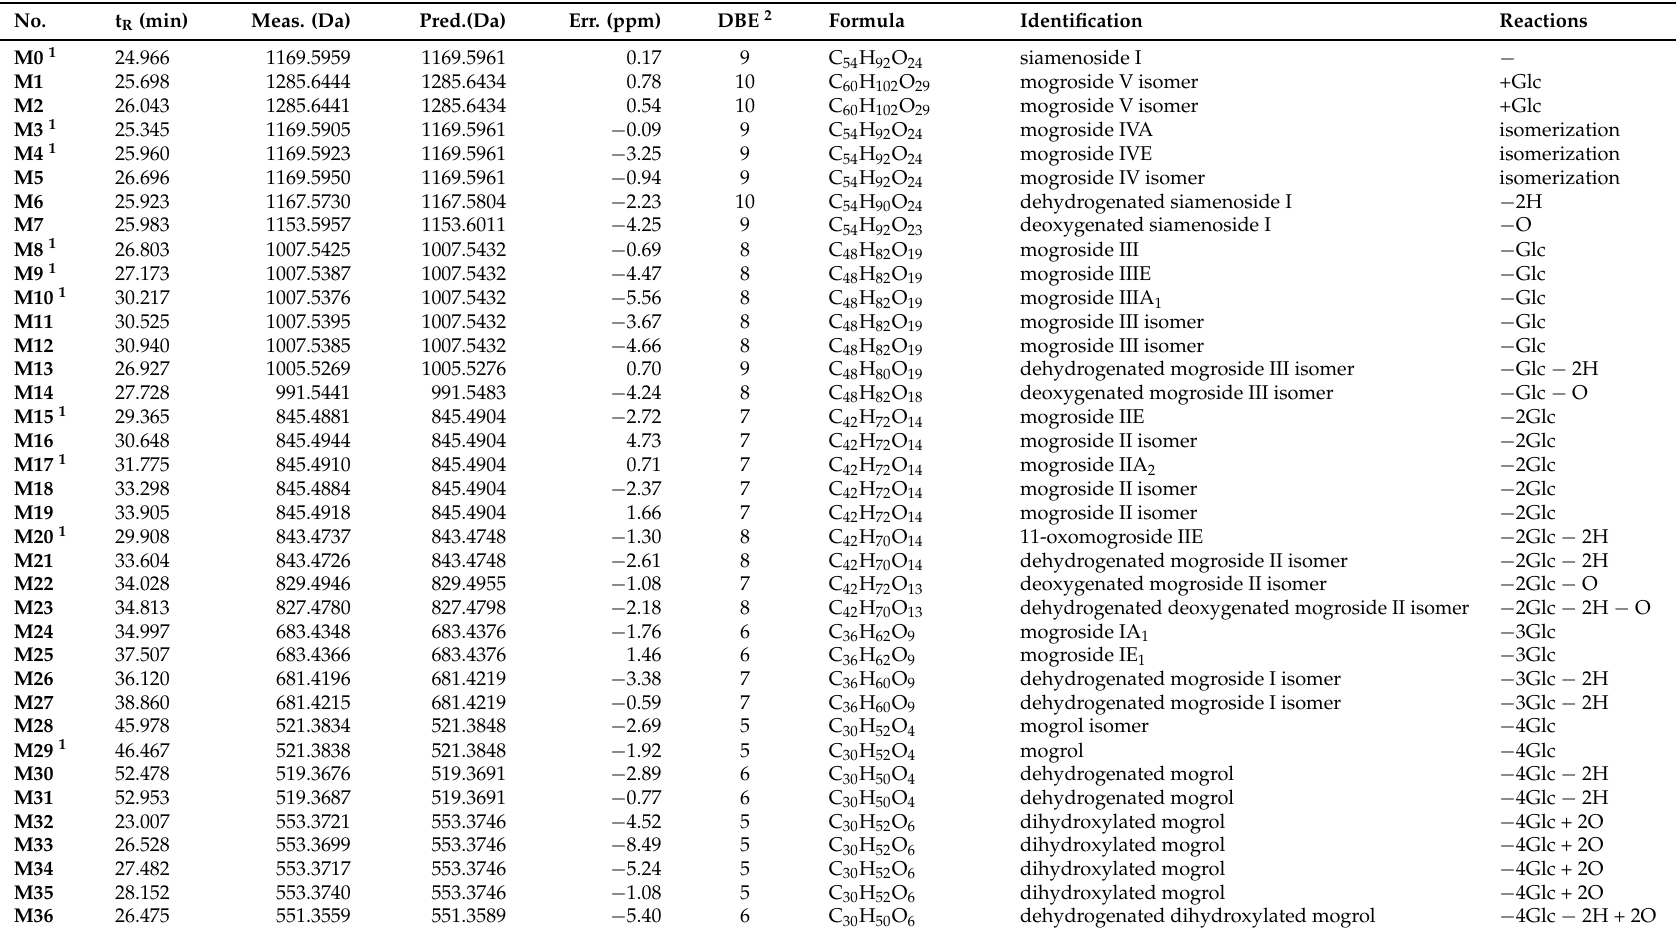
Table 1. LC-MS data of siamenoside I and its 86 metabolites formed in rats and their formative